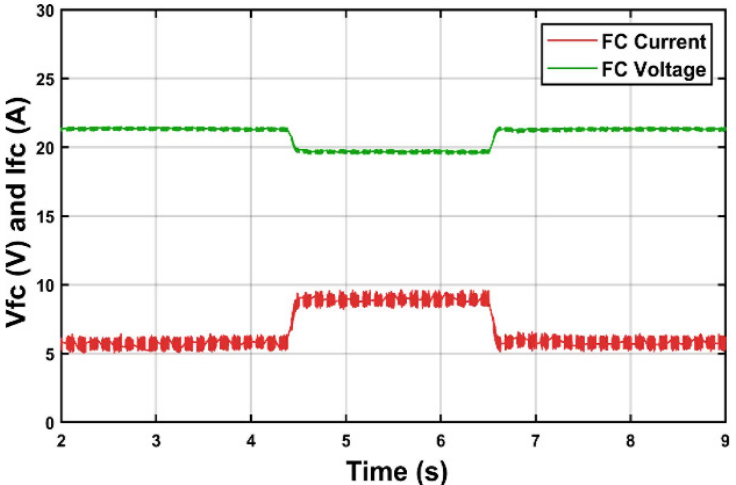
Figure 17. PEMFC emulator’s current and voltage.